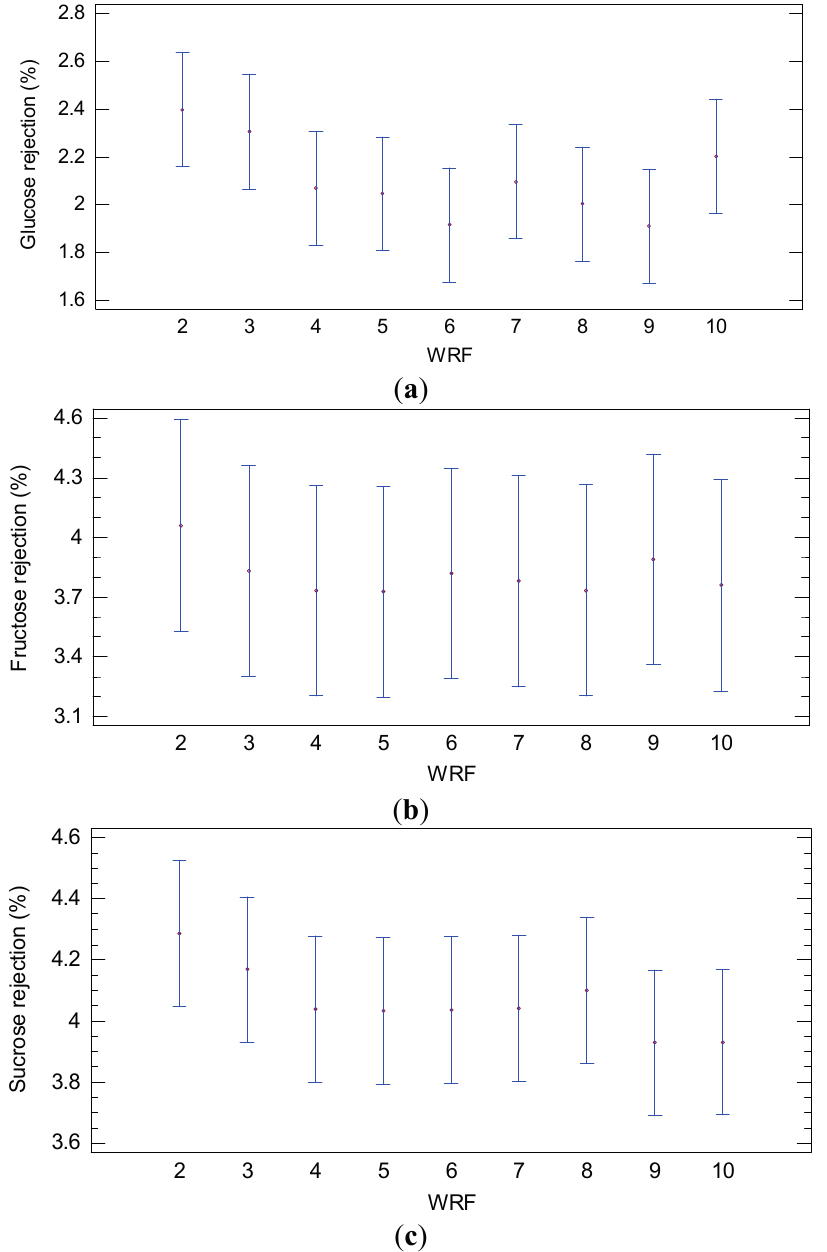
Figure 8. Least significant difference (LSD) plot showing the effect of WRF on the rejection of ( a ) glucose ( b ) fructose and ( c ) sucrose (NP030 membrane, batch concentration configuration, 4 bar, 25